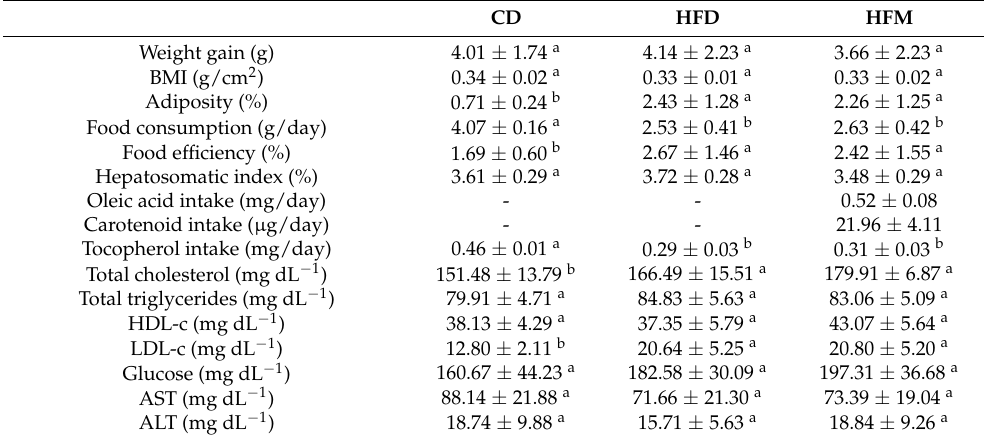
Table 4. Biometric measures, food intake, and serum biochemical values of the mice after consuming the experimental diets for 8